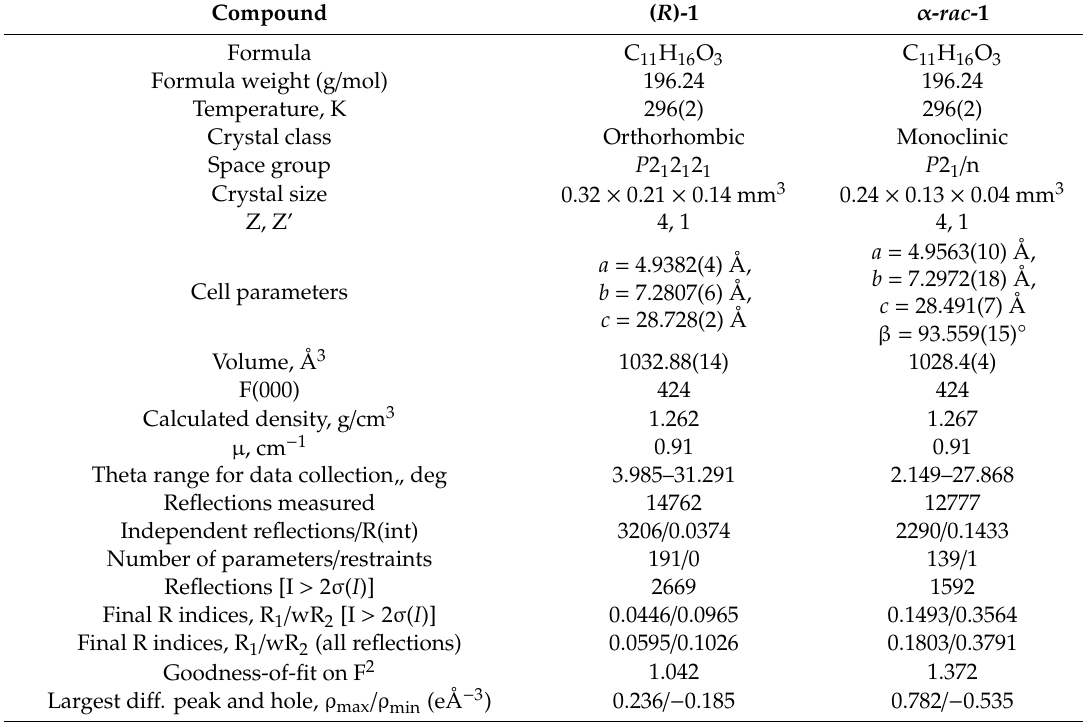
Table 1. Crystallographic data for ( R )- 1 and α - rac - 1 modifications of diol 1